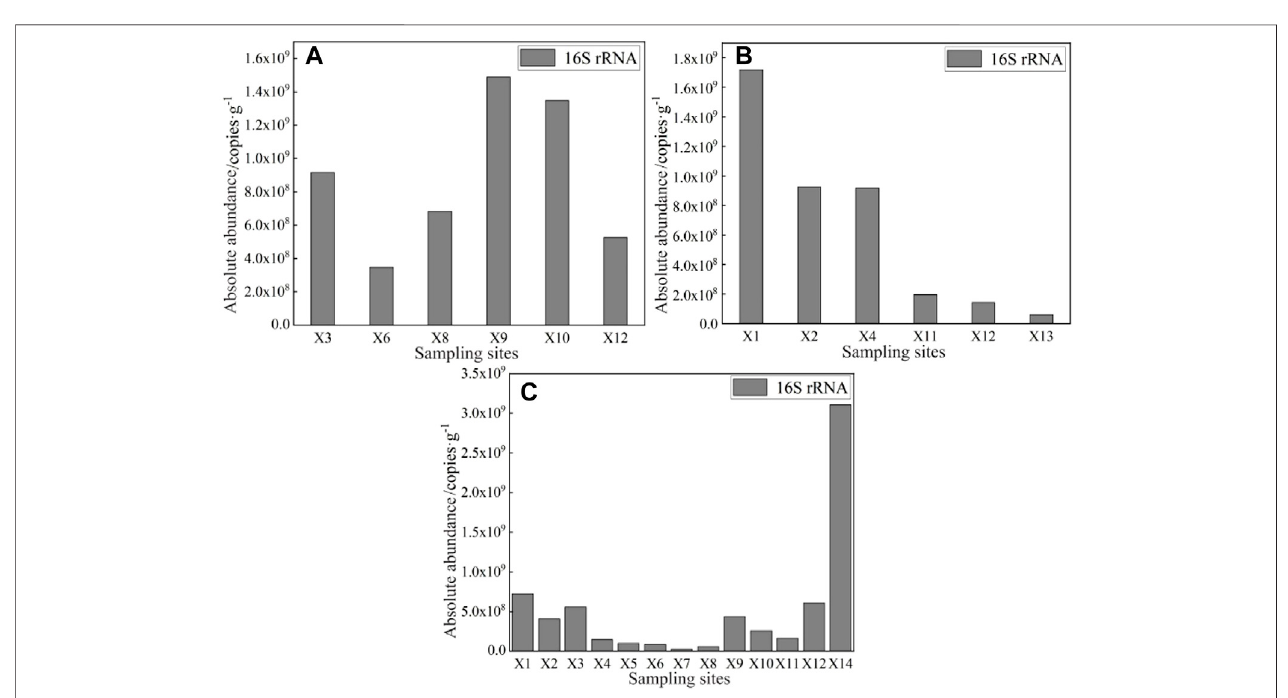
FIGURE 8 | Absolute abundance of 16S rRNA in surface sediments of East Dongting Lake in spring (A) , summer (B) , and fall (C) .